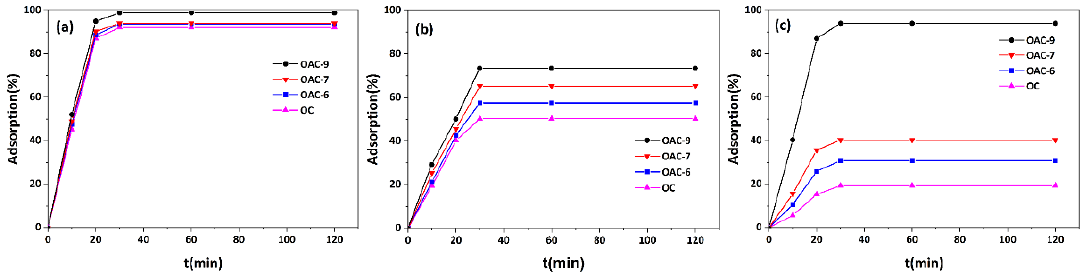
Figure 7. Adsorption rates of the adsorbents for 10 mg L − 1 of ( a ) MB, ( b ) TC, and ( c ) NaFL.